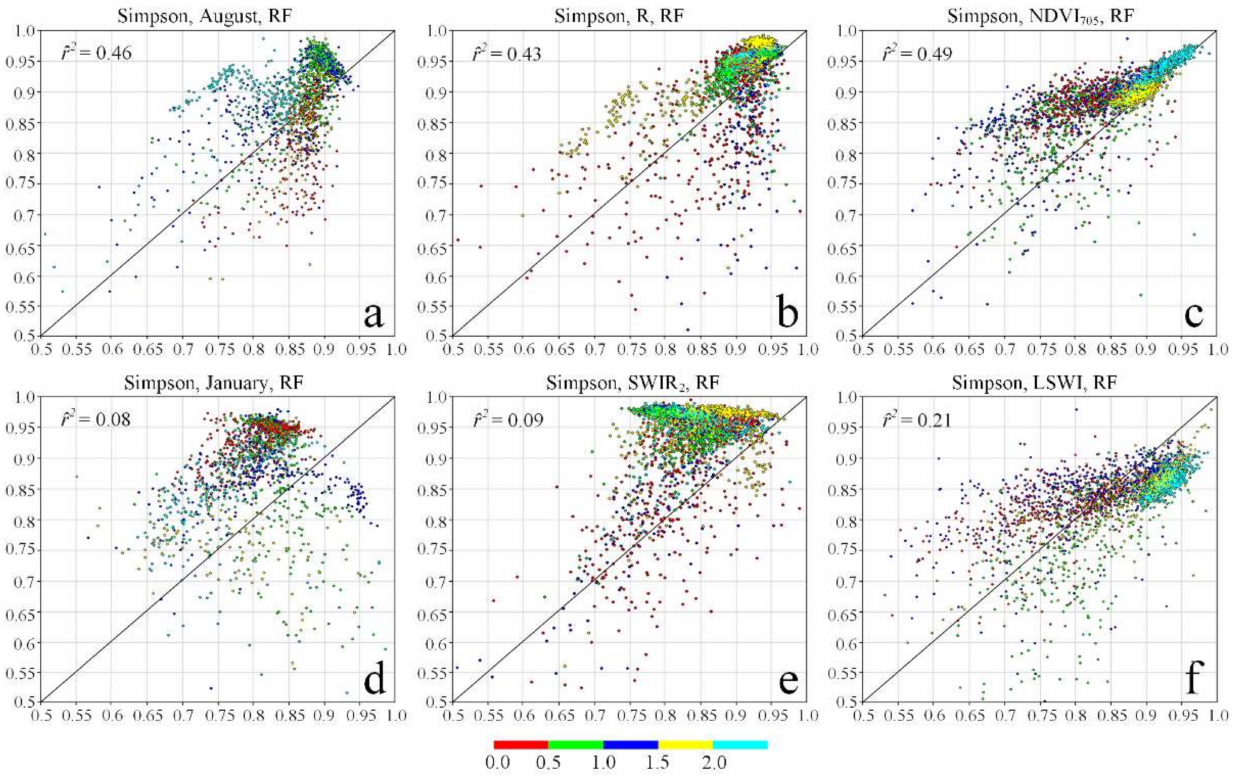
Figure 10. Scatter plots of the maximum and minimum accuracy using random forest (RF) methods to predict Simpson indices in images for acquisition month, spectral bands and VI features: ( a ) Simpson, August, RF; ( b ) Simpson, R (red); RF; ( c ) Simpson, NDVI 705 (normalized difference red edge), RF; ( d ) Simpson, January, RF; ( e ) Simpson, SWIR 2 (short-wave infrared), RF; ( f ) Simpson, LSWI (land surface water index), RF. The horizontal and vertical axes represent the y and ˆy values, respectively. The color plots are the confidence